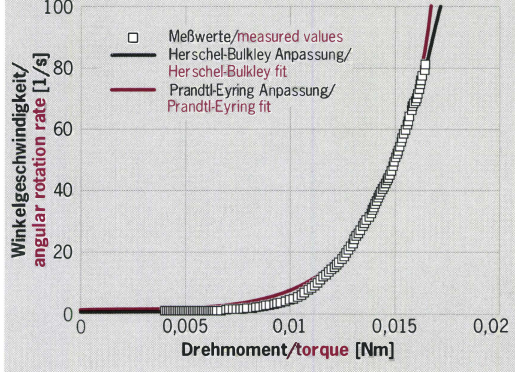
Fig. 2: The flow curves corresponding to the data and equation fits shown in